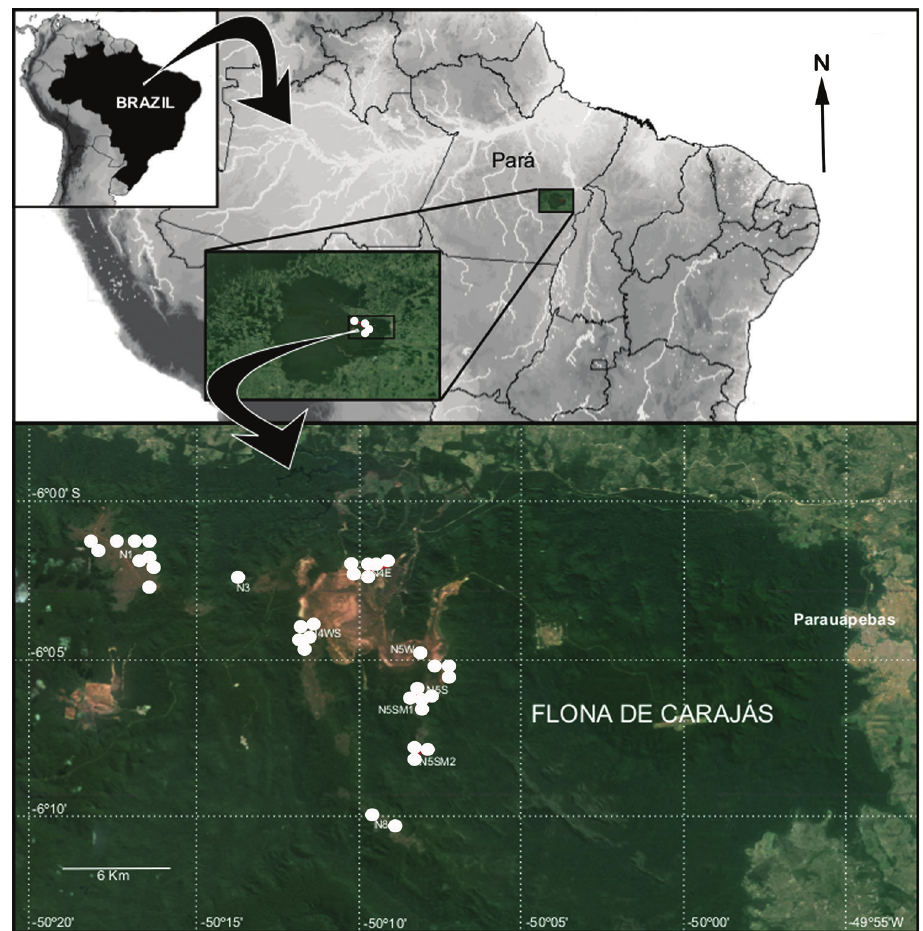
Figure 20. Distribution map of Carajas paraua sp. n. (white circles) from the Carajás area, northern